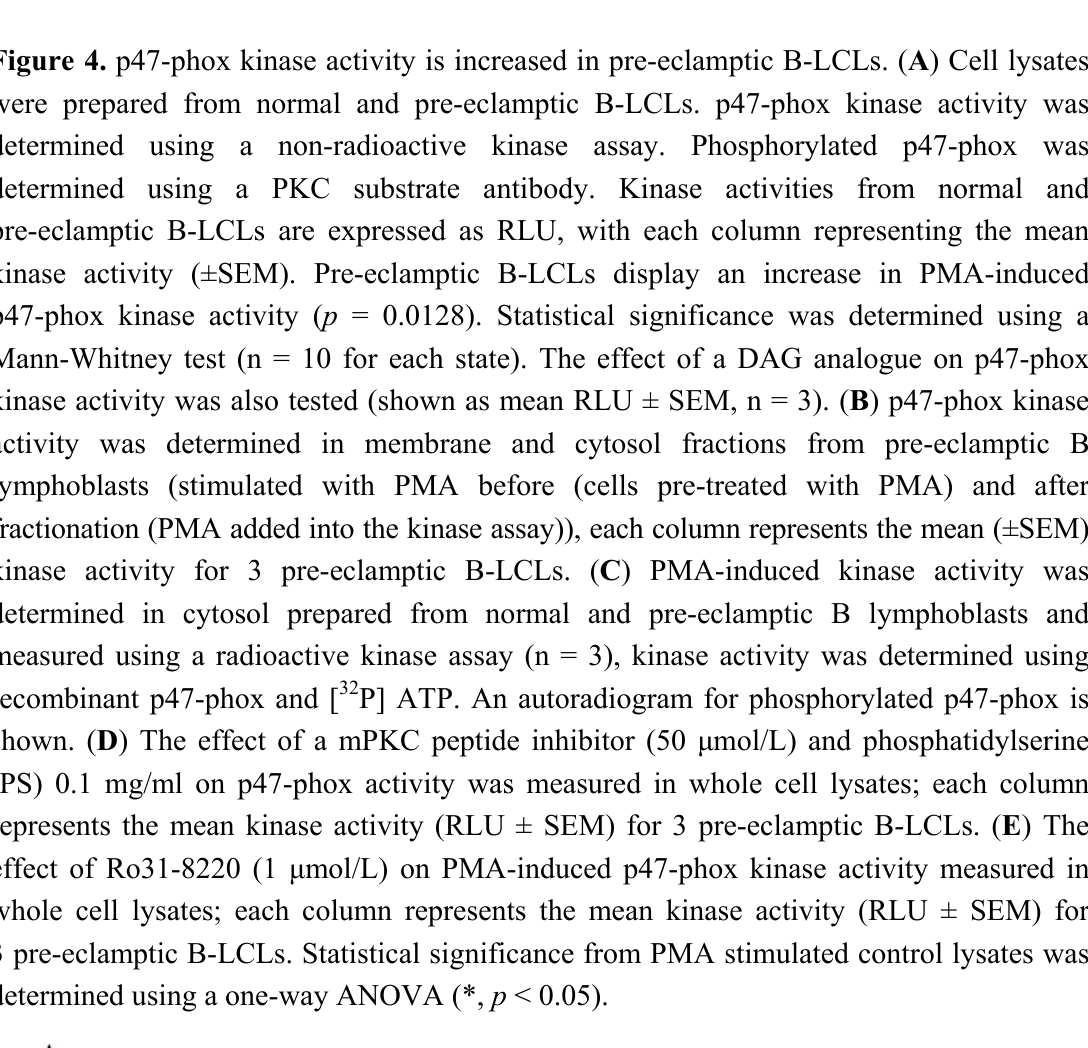
Figure 4. p47-phox kinase activity is increased in pre-eclamptic B-LCLs. ( A ) Cell lysates were prepared from normal and pre-eclamptic B-LCLs. p47-phox kinase activity